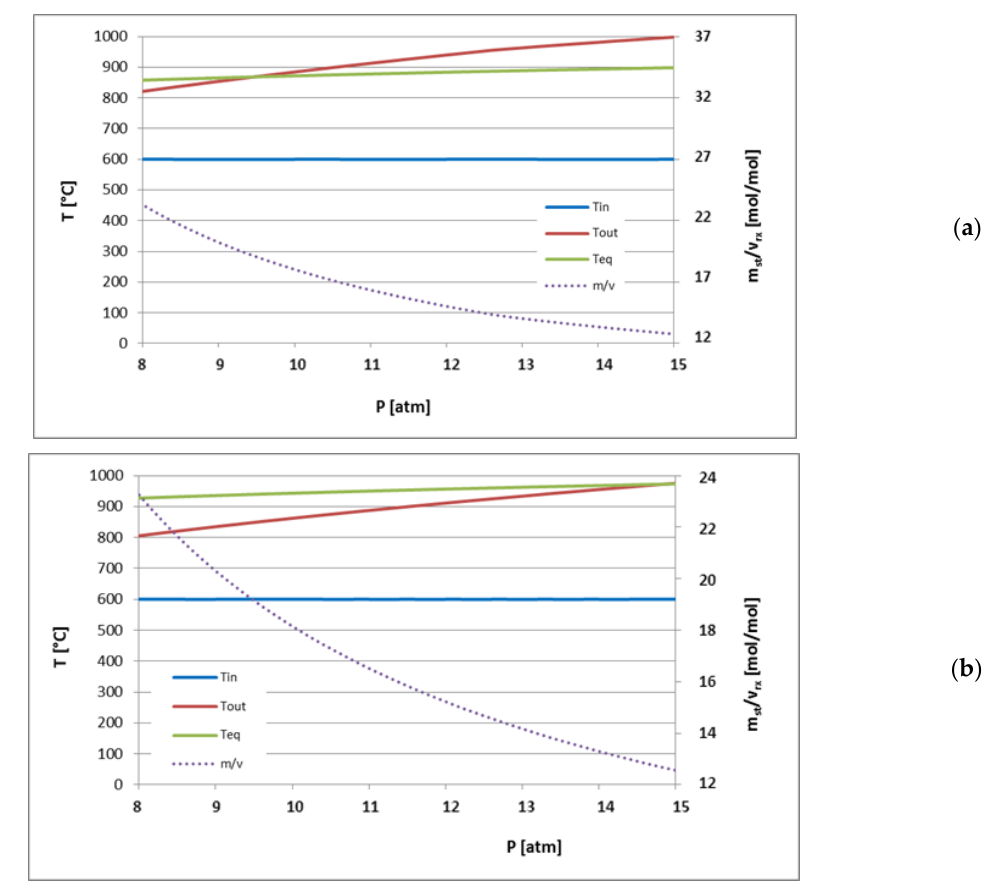
Figure 17. CaCO 3– CaO reactor (discharging step, closed loop): parametric analysis of the inlet and outlet temperature and equilibrium temperature varying the inlet total pressure (power block outlet pressure: 4 atm). ( a ) x CO2 : 0.2; ( b ) x CO2 : 0.07.